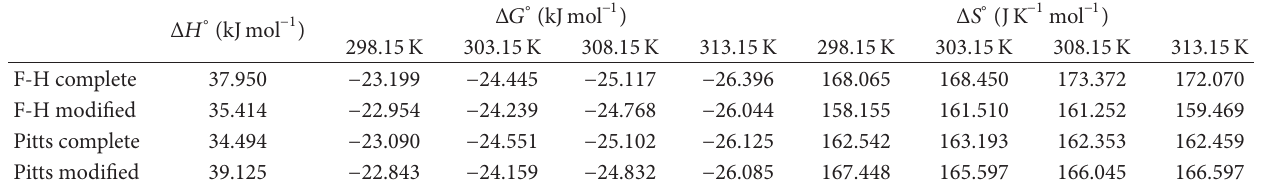
T 10: ermodynamic data for Cu-succinate.